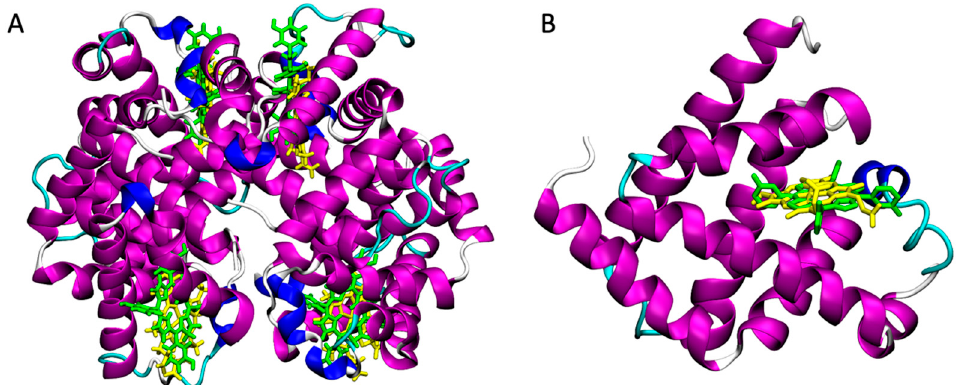
Figure 1. ( A ) Superposition of the crystallographic structure of heme (in yellow, PDB 2m6z) and docked structure of mTHPC (in green) in the heme-binding sites of Hb. ( B ) Superposition of the crystallographic structure of heme (in yellow, PDB 3rgk) and docked structure of mTHPC (in green) in the heme-binding site of Mb.